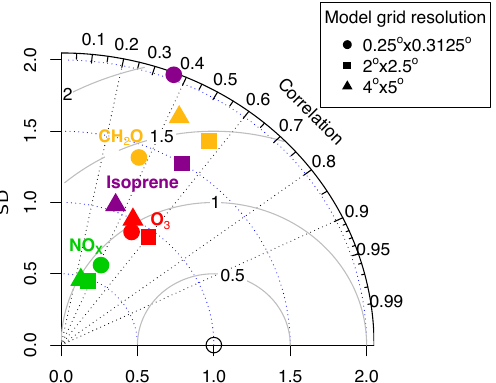
Figure 5. Taylor Diagram for NO x , isoprene, formaldehyde, and ozone concentration statistics sampled in the Southeast US mixed layer along SEAC 4 RS flight tracks (Figs. 1 and 4). GEOS-Chem model results at different grid resolutions are compared to observa- tions at the corresponding resolutions. Standard deviation is plotted along the radial coordinate, while the angular coordinate denotes the Pearson’s correlation coefficient between model and observa- tions. Model standard deviation is normalized to the observations, so that a value above 1 indicates greater variance than observed. The open circle located at (1, 1) represents the observations. The grey arcs represent the root-mean-squared error between model and observations after the mean bias has been removed.